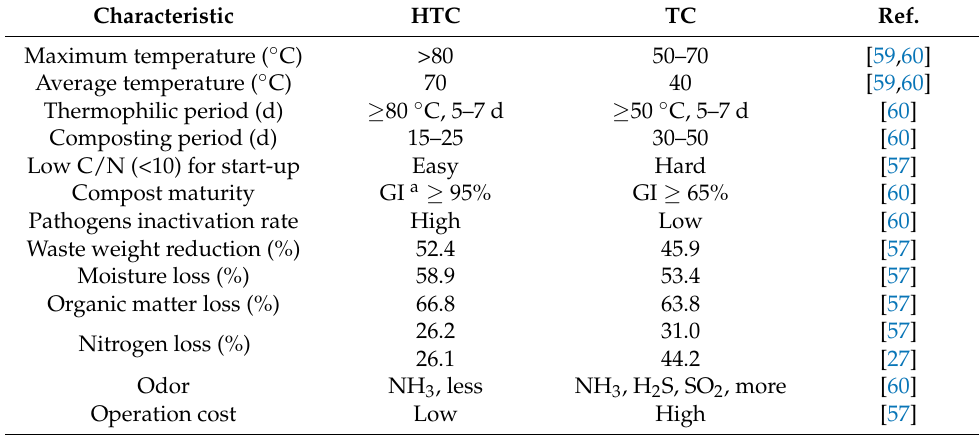
Table 1. Feature comparison of hyperthermophilic composting (HTC) and thermophilic composting (TC) for organic solid waste